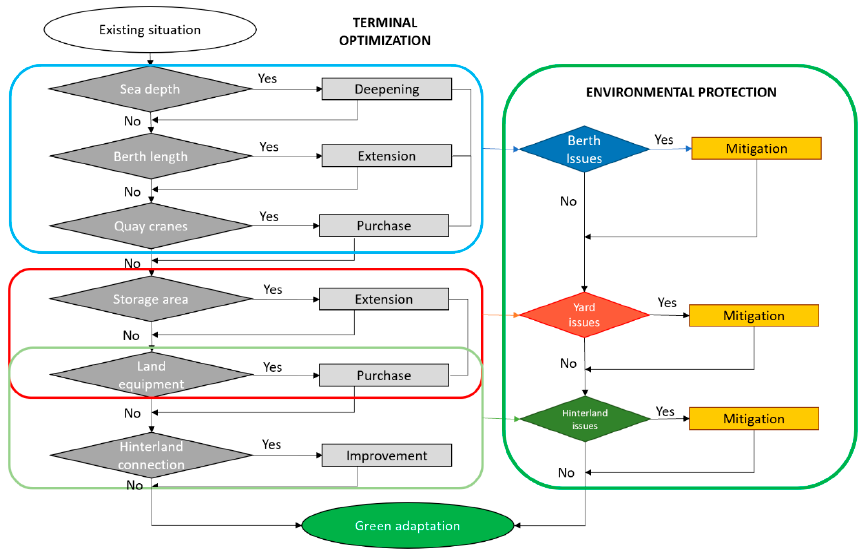
Figure 2. Comprehensive Decision Support Tool (DST)